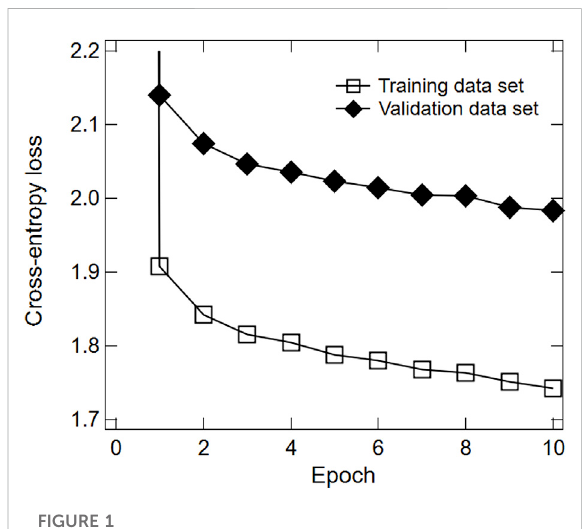
FIGURE 1 ( □ ) Training and ( A ) validation losses of